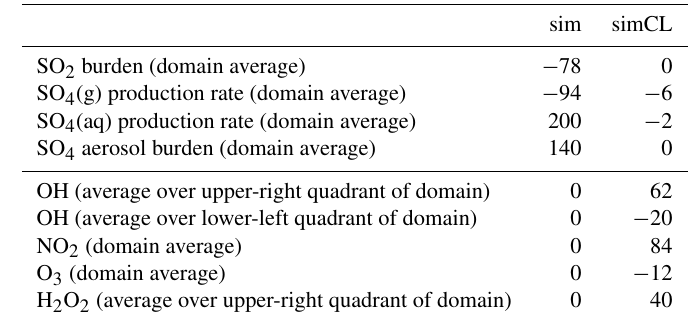
Table 6. Horizontal averages of relative differences. (cid:49) = 2 ( simAQ − x )/( simAQ + x ) between different M7 chemistry setups in percent for the simAQ simulation in comparison to simulations x = sim, simCL. Values of SO 2 and SO 4 correspond to Fig. 6, where the productions rates are vertically integrated. Differences in oxidant fields are based on weighted vertical averages as in Fig. 2, with the gas-phase production rate of SO 4 as weight for the gas-phase oxidant OH and gas-phase oxidant precursor NO 2 and weighted with the aqueous-phase reaction rate for the aqueous-phase oxidants H 2 O 2 and O 3 . Where the sign of a difference signal is not uniform throughout the domain, representative quadrants have been